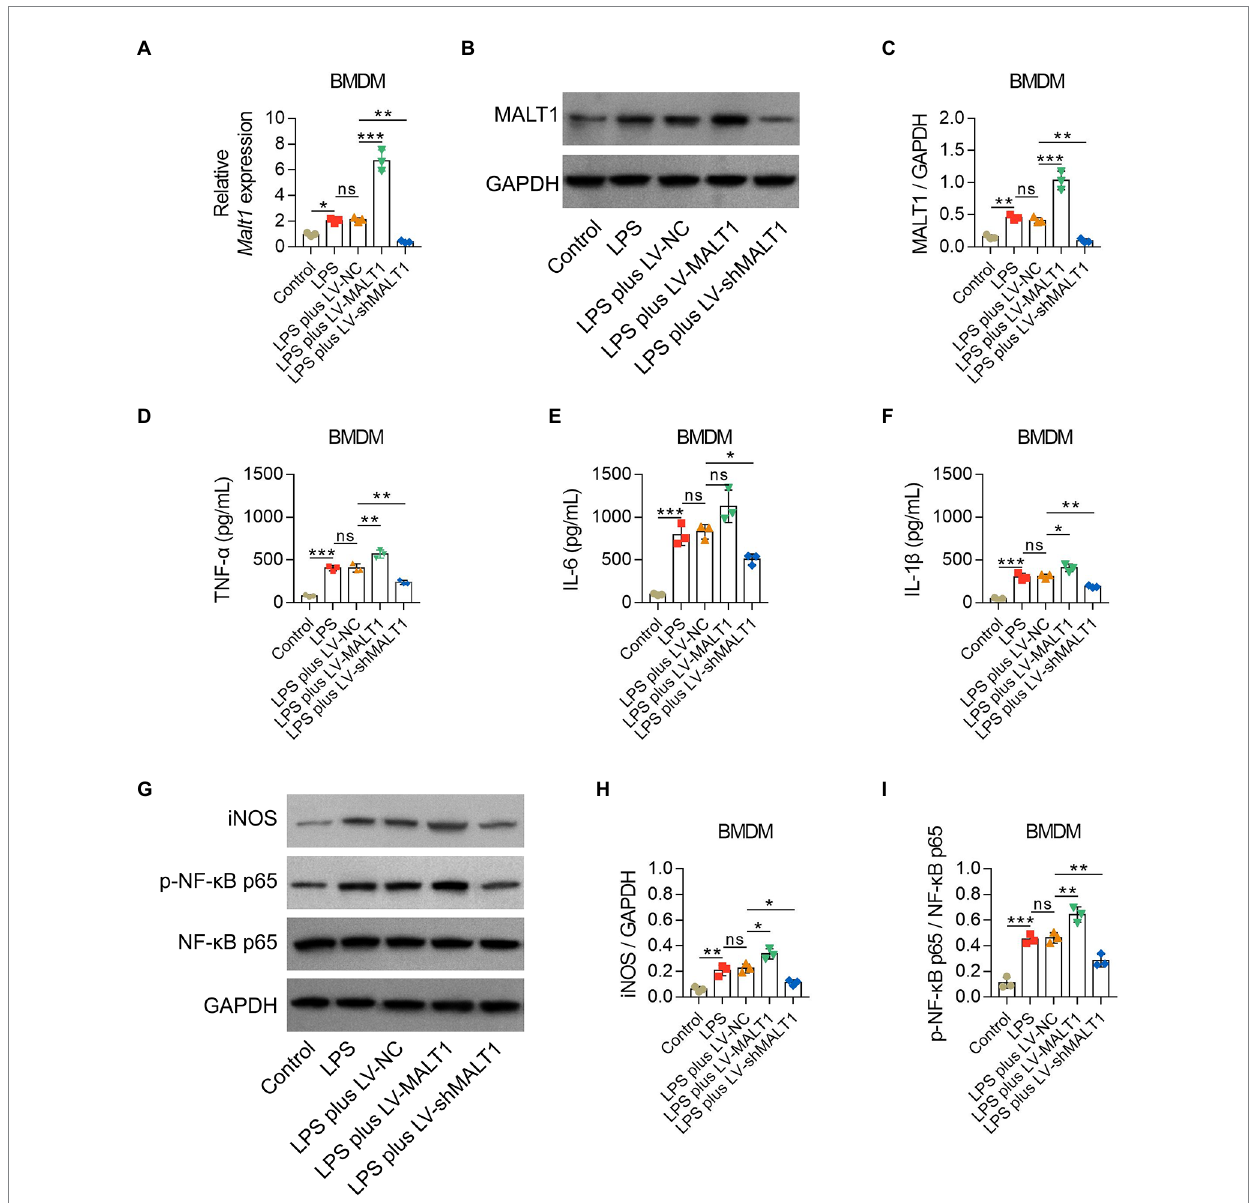
FIGURE 8 Effect of MALT1 on M1 polarization of LPS-treated macrophages. Comparison of MALT1 mRNA levels (A) and protein levels ( B , C ) among Control, LPS, LPS plus LV-NC, LPS plus LV-MALT1, and LPS plus LV-shMALT1 groups. Comparison of TNF- α ( D ), IL-6 (E) , and IL-1 β (F) among Control, LPS, LPS plus LV-NC, LPS plus LV-MALT1, and LPS plus LV-shMALT1 groups. Western blot detection of iNOS and p-NF- κ B p65 (G) and comparison of the relative protein levels of iNOS (H) and p-NF- κ B p65 (I) among Control, LPS, LPS plus LV-NC, LPS plus LV-MALT1, and LPS plus LV-shMALT1 groups. n = 3 in each group. One-way ANOVA plus Tukey’s post hoc test was applied. Ns, not significant; * p < 0.05; ** p < 0.01; *** p <